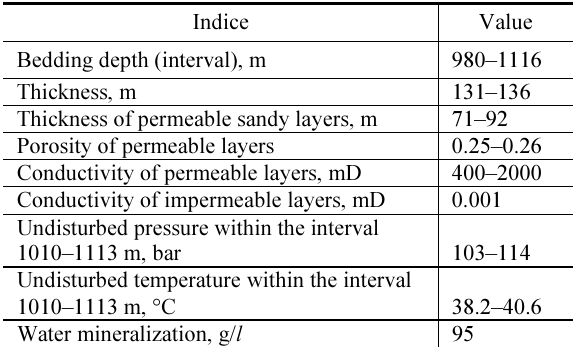
Table 1 . Indices of the Lower Devonian Viešvilė complex (aquifer) in wells of the